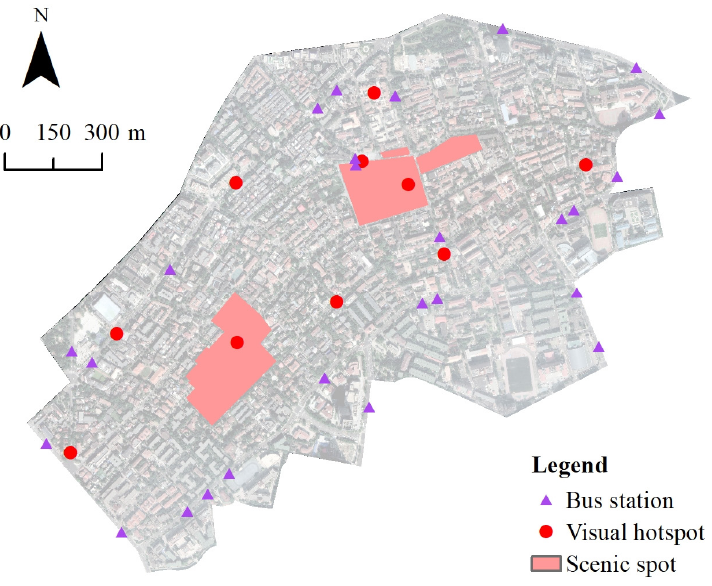
Figure 4. Bus stations, visual hotspots, and scenic spots.